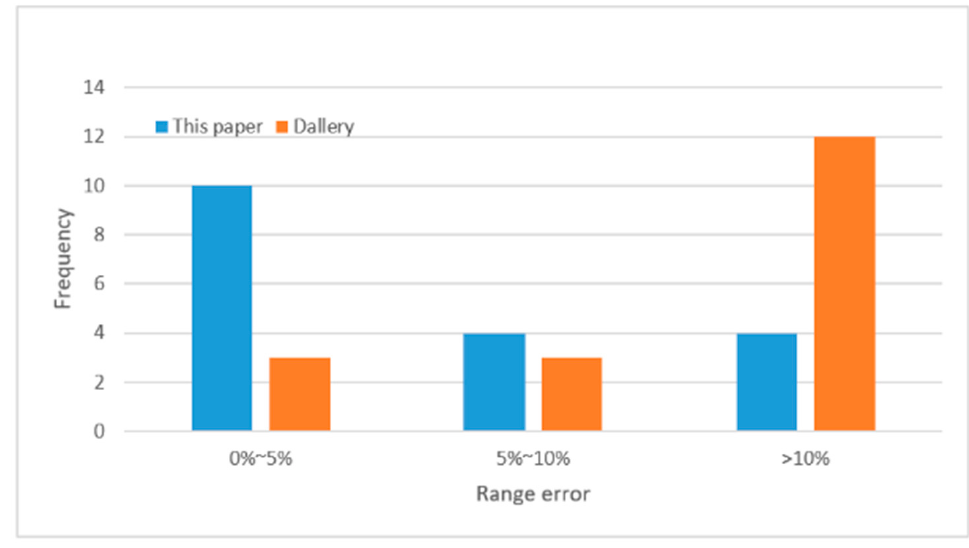
Figure 12. Error comparison chart.